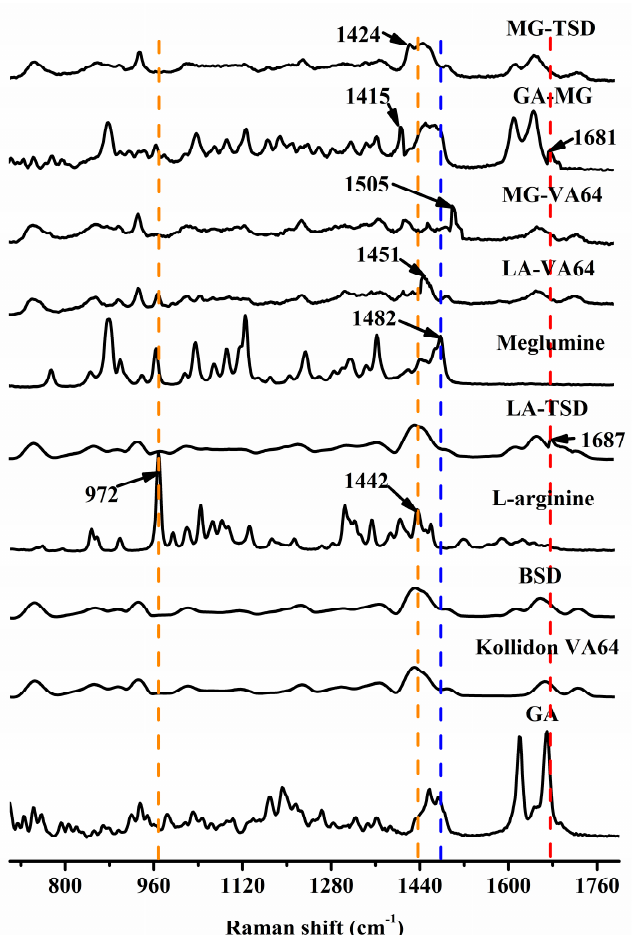
Figure 9. Raman spectra of GA, Kollidon ® VA64, and their PMs / SDs with and without alkalizers in the wavenumber range of 700 to 1800 cm − 1 .